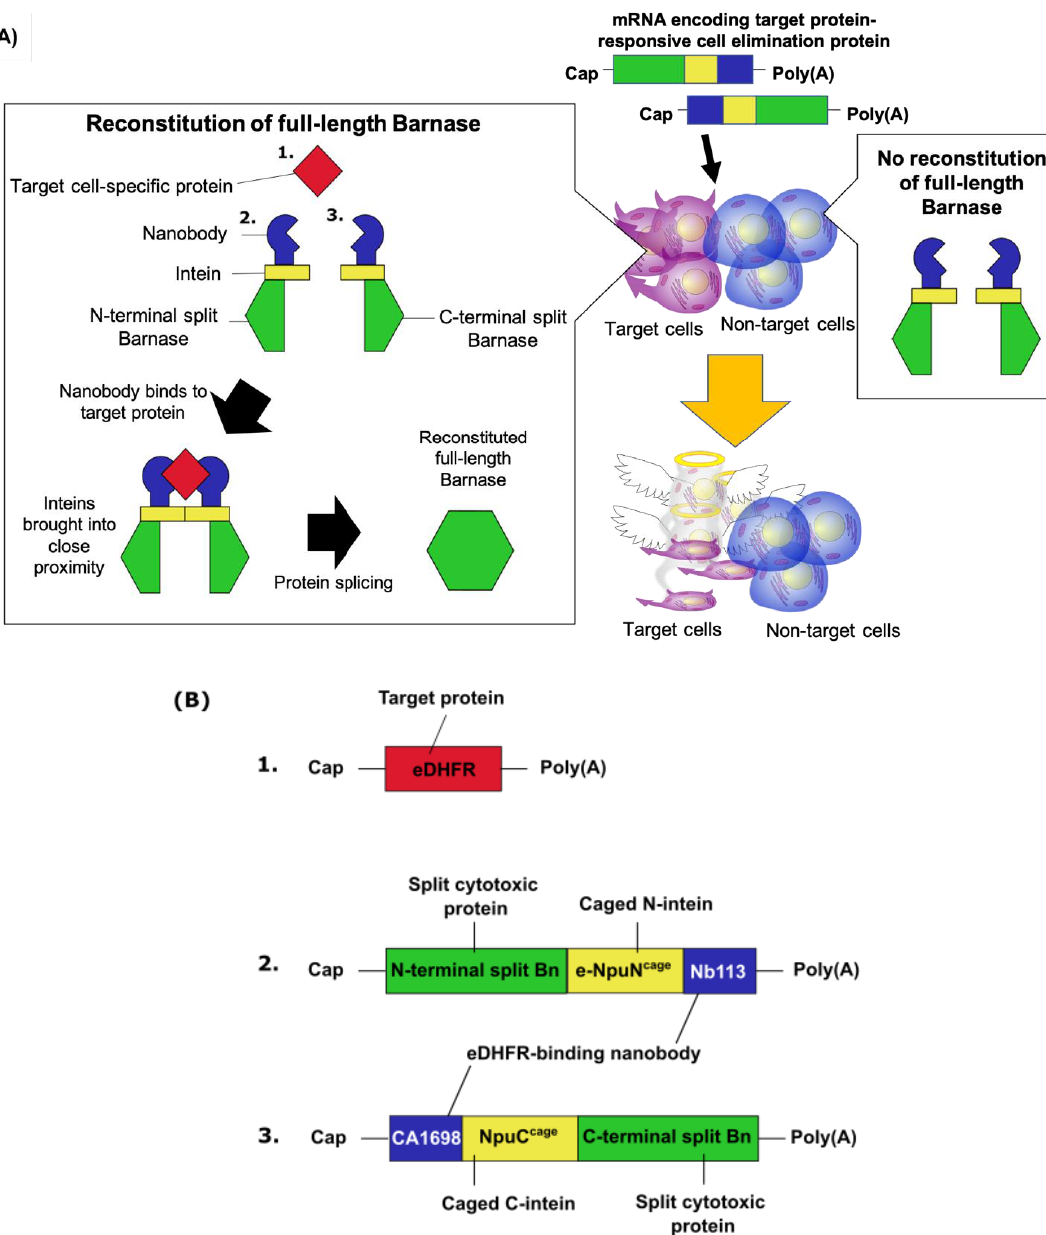
Figure 1. Mechanism of selective cell elimination using mRNA encoding split Bn. ( A ) Schematic diagram of selective cytotoxicity after transfecting the mRNA encoding target protein-responsive cell elimination protein. ( B ) Schematic diagram of mRNAs used in the target protein-responsive cell elimination system. All mRNAs were capped with CleanCap AG ( 3′ OMe).